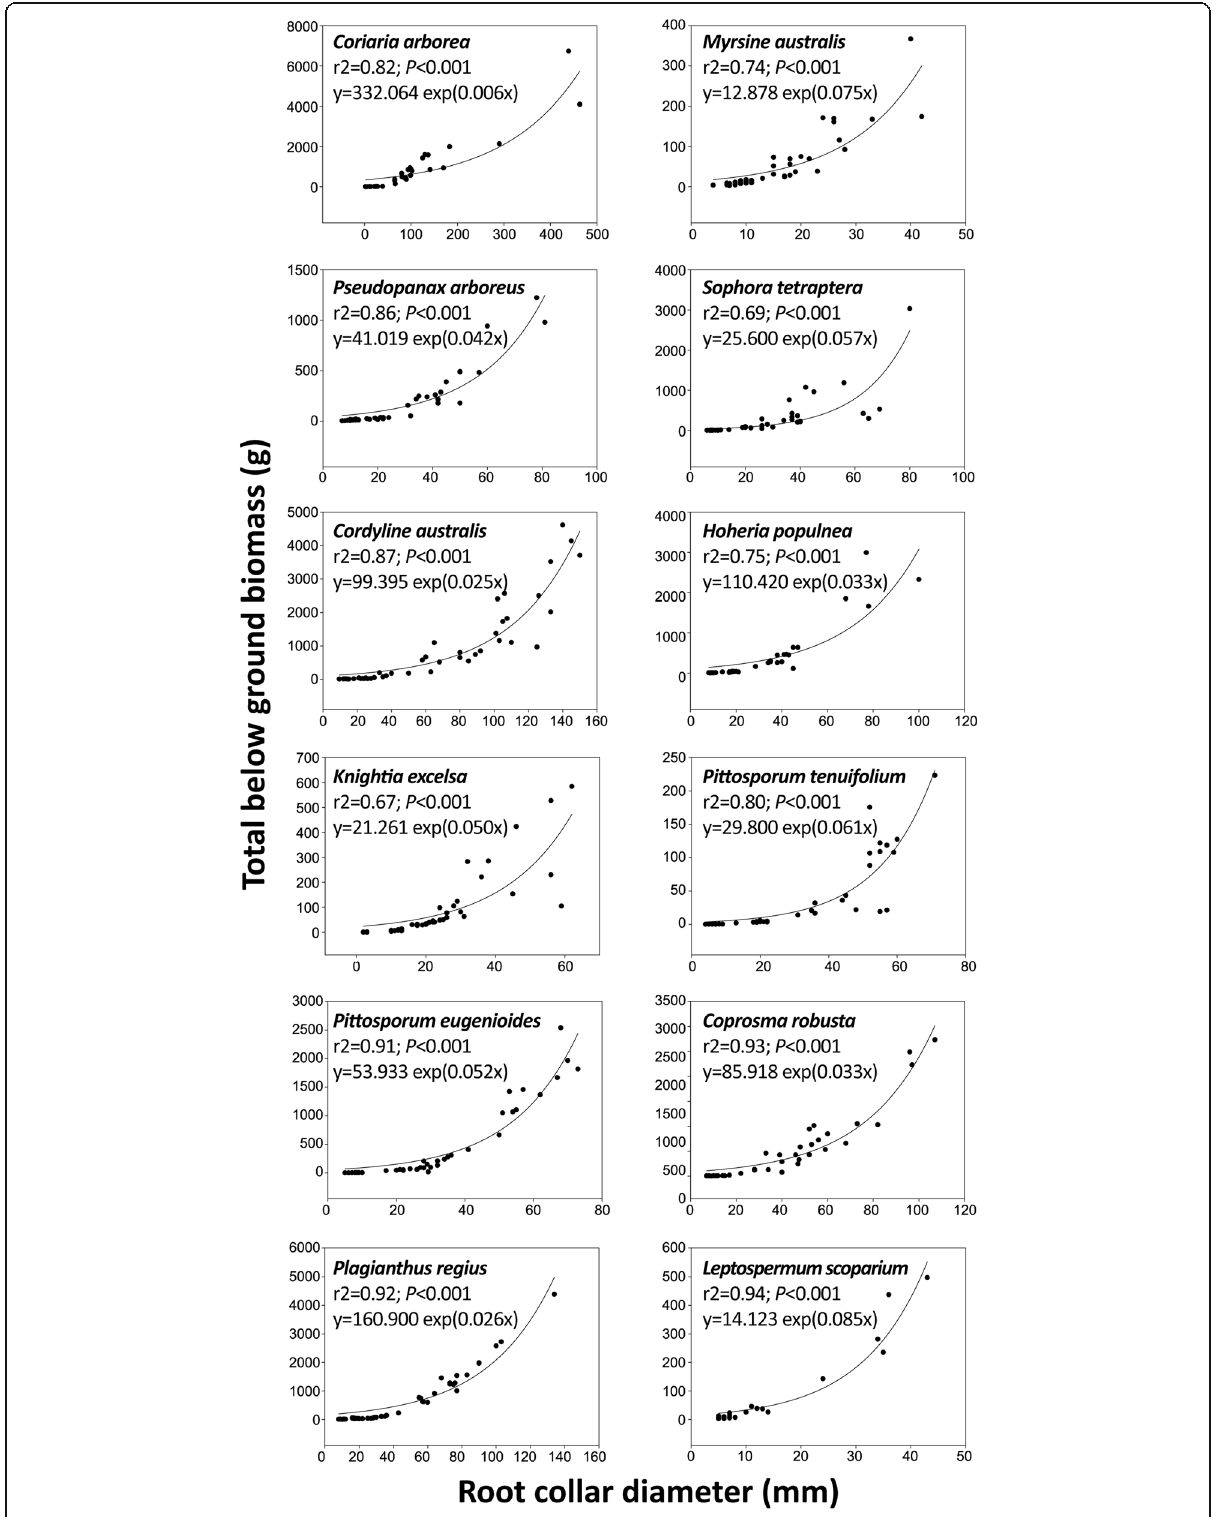
Fig. 3 Exponential growth analysis of RCD and total below-ground